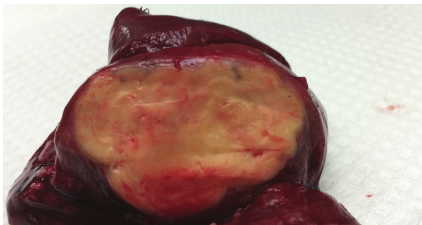
Figure 4: Right lower lobe wedge resection gross surgical specimen: the solid nodule measuring 3.6 cm demonstrating smooth lobulated contours and a yellow-tan resilient